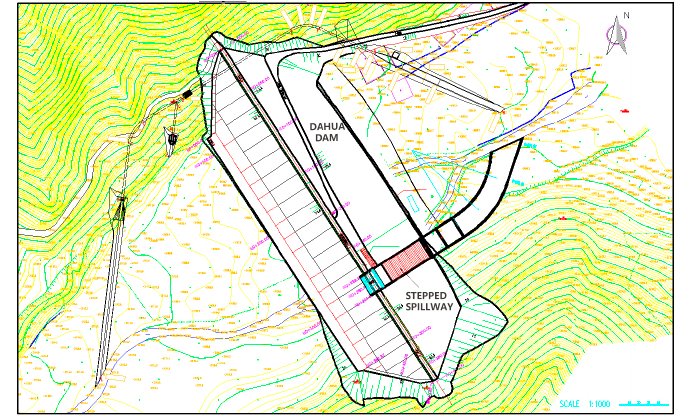
Figure 1. Schematic layout of Dahua Dam and its spillway.